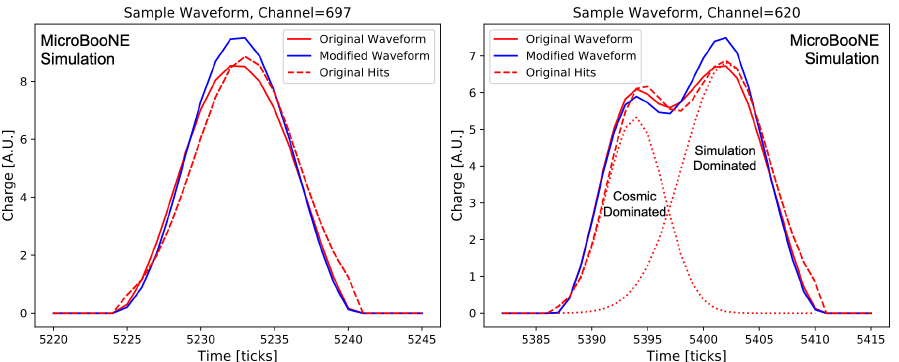
Figure 3. Examples of the original and modified waveforms for a single hit ( left ) and two concurrent hits from a cosmic ray muon overlaid in simulation and a simulated physics interaction ( right ). Only the waveform from the simulated physics event was modulated to form the new hit in the varied sample. The images come from